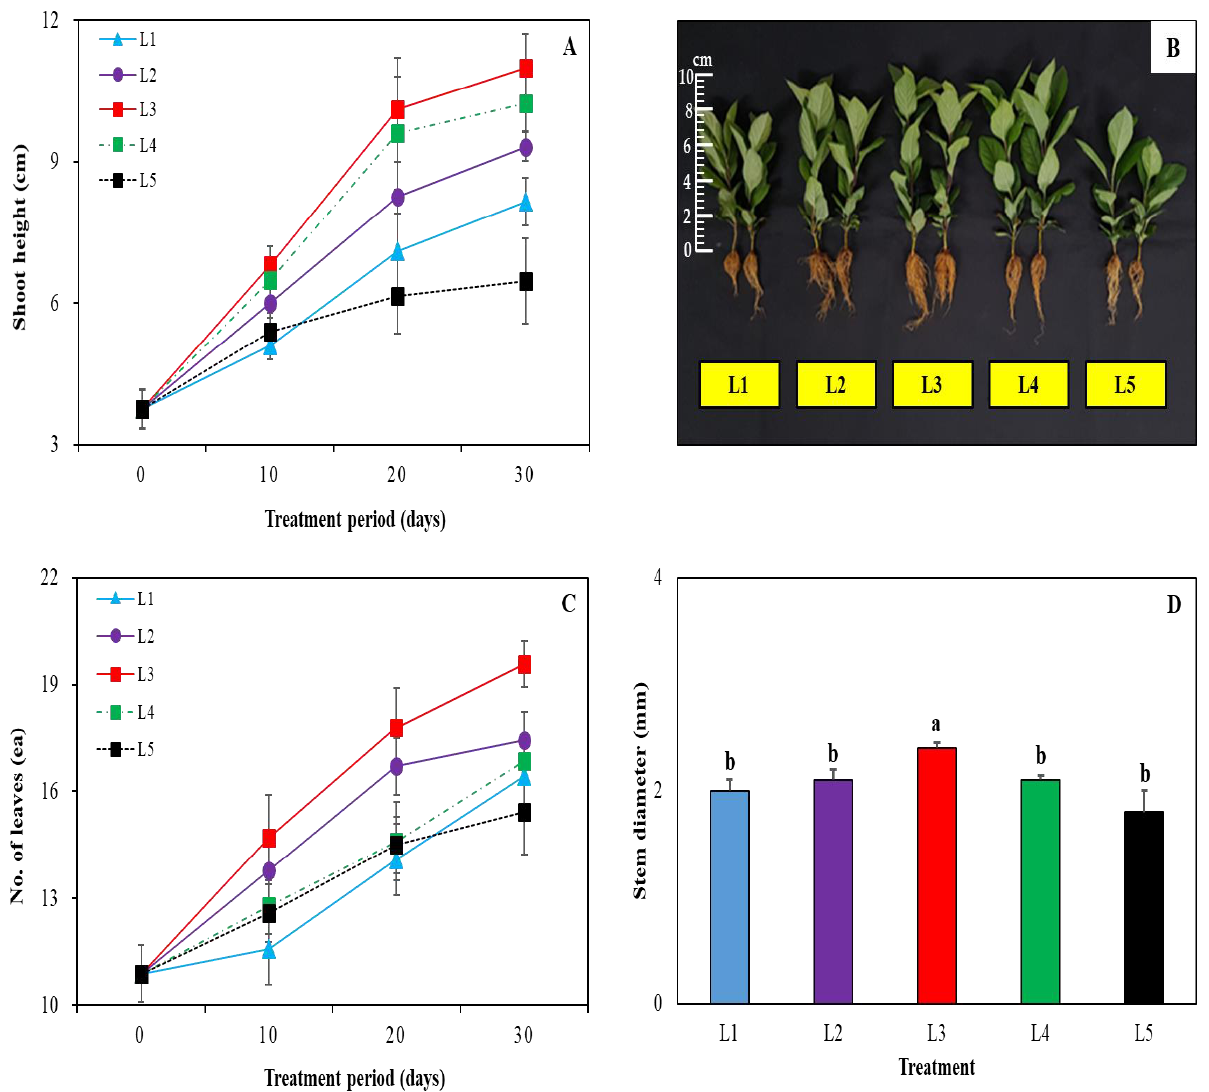
Figure 2. Effect of light intensity on the shoot height ( A ), growth morphology ( B ), number of leaves ( C ) and stem diameter ( D ) of apple seedlings at 30 days after treatment in a controlled environment. L1, L2, L3, L4 and L5 indicate light intensity (Table 3). Lines in the graph represent the standard error of the mean (n = 5). Means above each bar followed by the same letters are not significantly different by Duncan’s multiple range test (DMRT) at p ≤ 0.05.